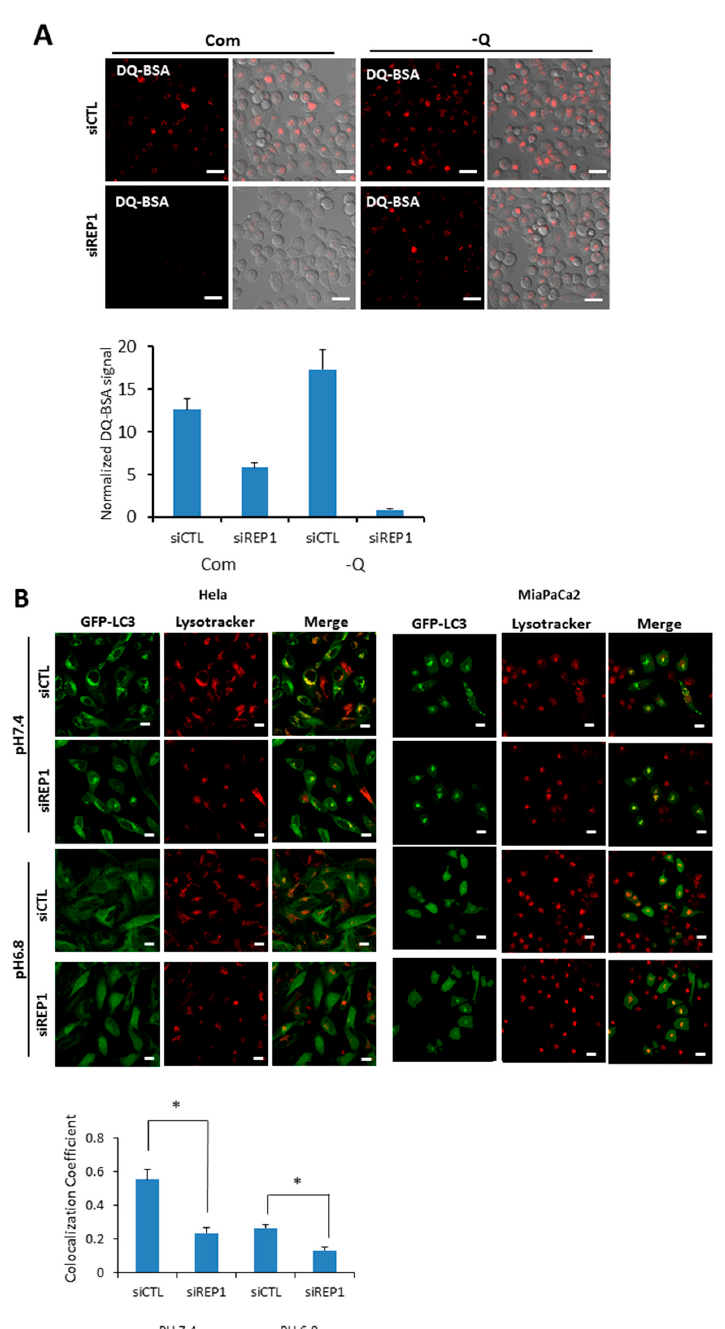
Figure 4. REP1 depletion changes lysosomal function and intracellular localization. ( A ) MiaPaCa2 cells were treated with CTL or REP1 siRNA and incubated for 48 h. Then the cells were treated with DQ-BSA at a final concentration 10 μ g/mL for 30 min. Intracellular fluorescent signals were analyzed by fluorescence microcopy and presented as quantification values based on images; ( B ) Hela and MiaPaCa2 cells stably transfected with GFP-LC3 were treated with CTL or REP1 siRNA and incubated for 24 h. Then the cells were further incubated in the media with pH 7.4 or 6.8 overnight and cells were treated with a lysotracker for 30min. Intracellular fluorescent signals were analyzed by fluorescence microcopy and co-localization levels were presented as co-localization coefficient based on image quantification. Error bars indicate mean +/ − standard error for n = 3 independent experiments. Statistical significance was determined via a Student’s t -test; * p < 0.05.